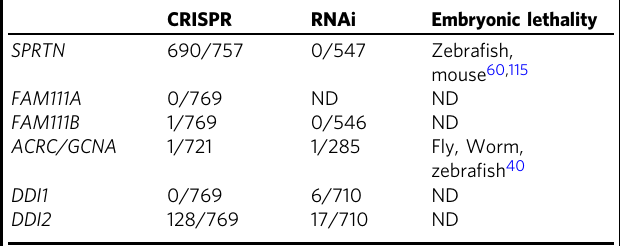
Table 1 Essentiality of genes encoding for DPC